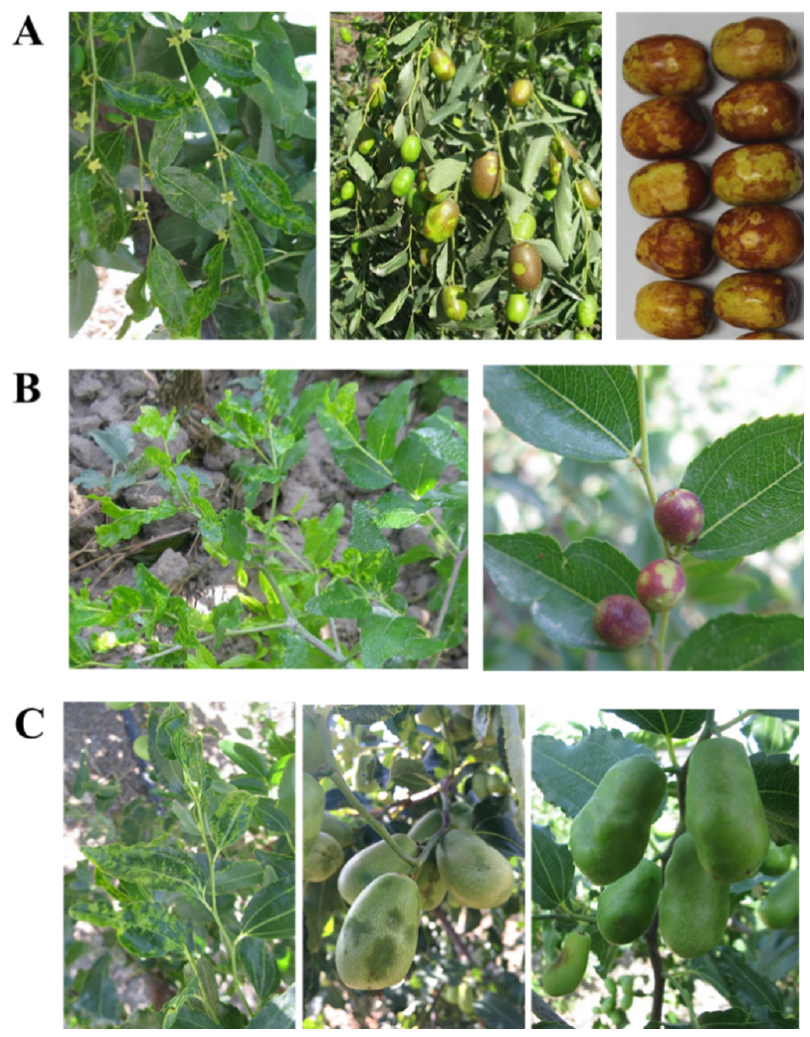
Figure 7. Disease symptoms on leaves and fruits of Ziziphus jujube cv. ‘Huizao’ ( A ), Z. jujuba var. ‘spinosa’ ( B ) and Z. jujuba cv. ‘Junzao’ ( C ). To understand the incidence of JYMaV and its association with the observed disease, 85 jujube leaf samples, including 61 symptomatic leaf samples, 14 asymptomatic leaf sam- ples from Aksu area in Xinjiang Uygur Autonomous region of China and 10 asymptomatic leaf samples from Shanxi Province, were subjected to RT-PCR assays for JYMaV using three primer sets 3-F/3-R, 5-F/5-R and 6-F/6-R. Results showed that JYMaV was exclu- sively detected in the jujube leaf samples showing chlorotic leaf spots (Table S4). Out